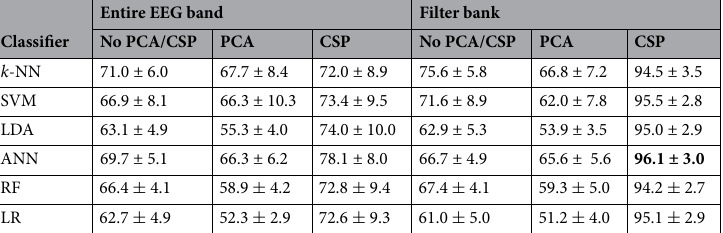
Table 4. Accuracy (mean and standard deviation) without considering a priori knowledge i.e. Asymmetry - Within-subject. The best performance value is highlighted in